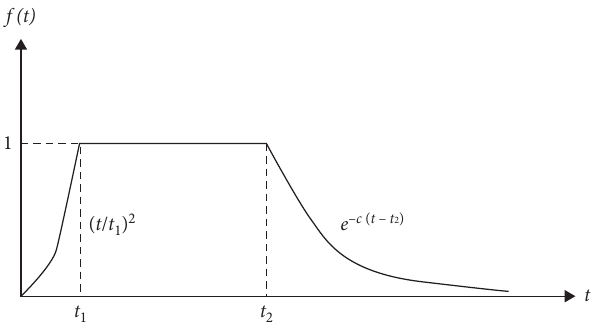
Figure 4: f ( t ) density function to create unsteady function.